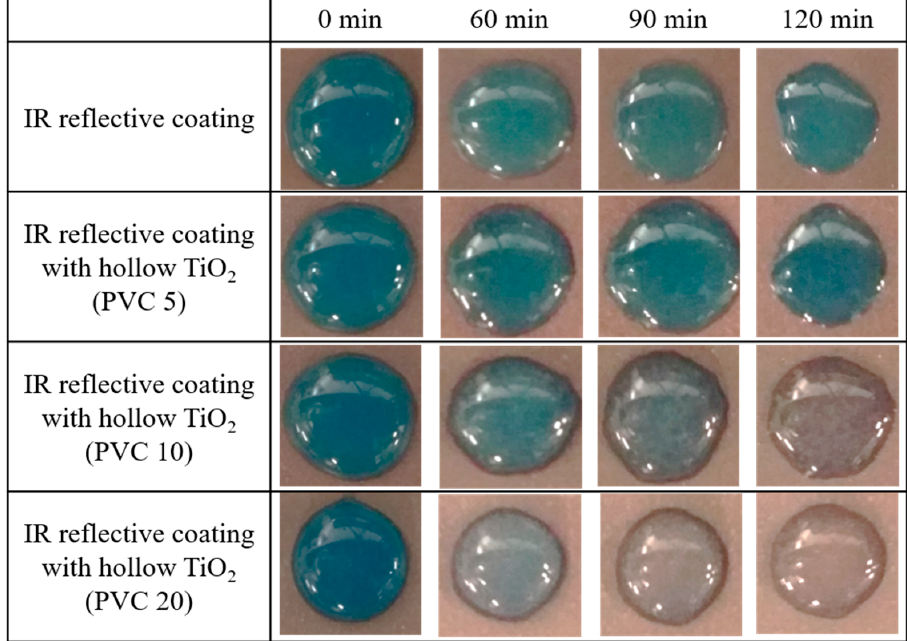
Figure 13. Visual images of methylene blue decomposition with UV exposure time.